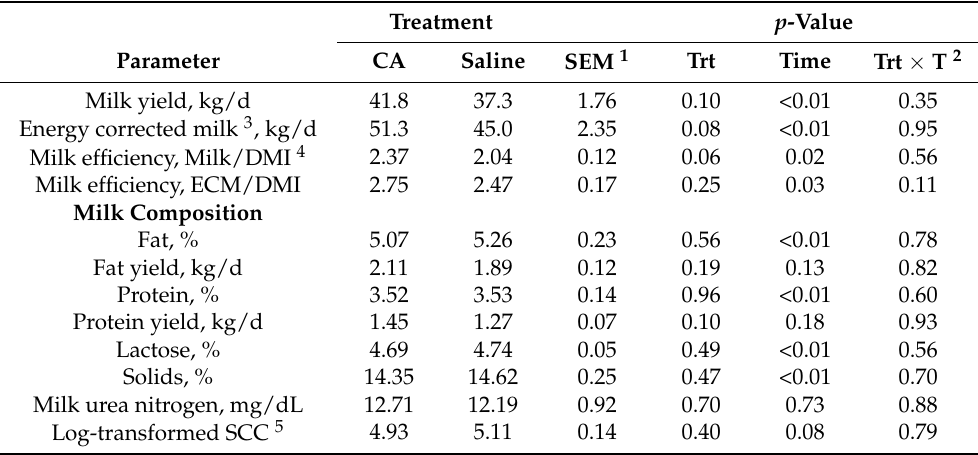
Table 4. Main residual effects of intravenous infusion of carnosic acid (CA) or saline solution (Saline) on milk production and composition parameters during 21 d in